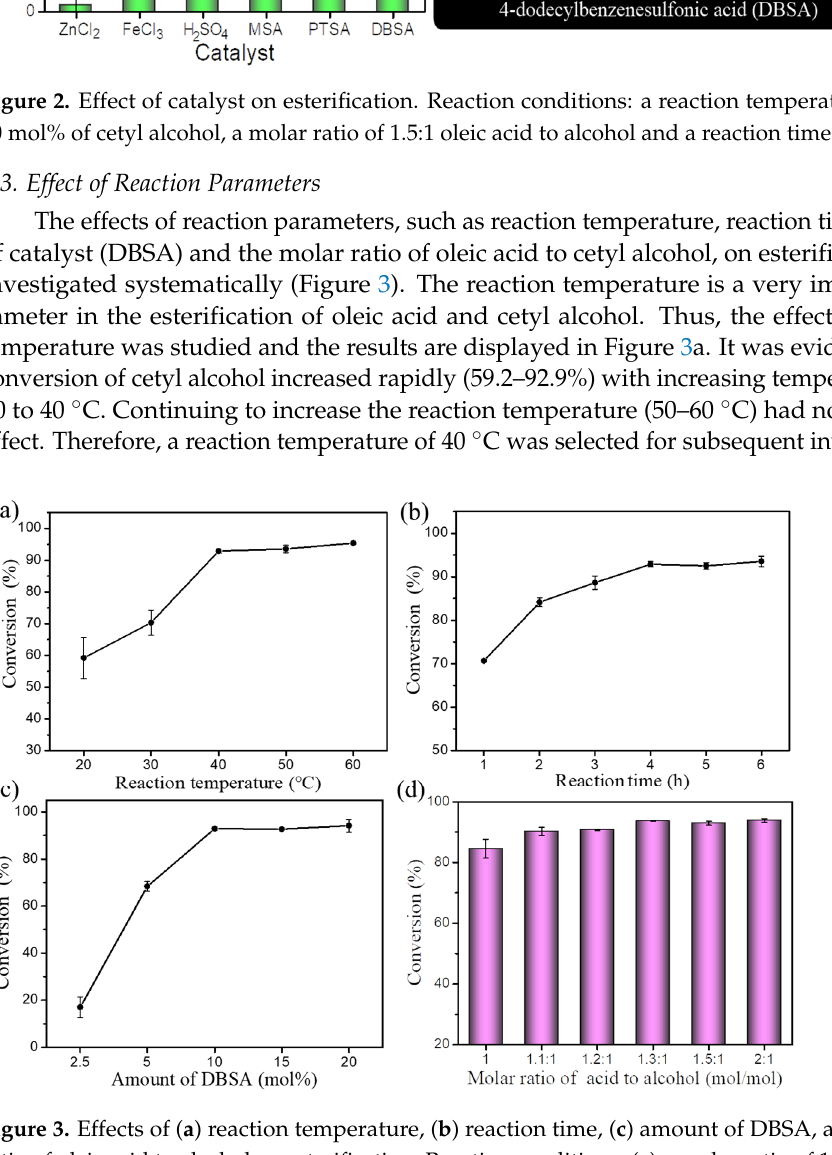
Figure 2. Effect of catalyst on esterification. Reaction conditions: a reaction temperature of 40 °C, 10 mol% of cetyl alcohol, a molar ratio of 1.5:1 oleic acid to alcohol and a reaction time of 4 h.